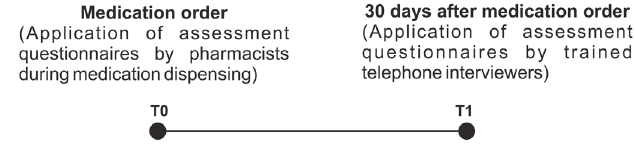
FIGURE 3 – Evaluation time points for assessing the drug dispensing service at the university